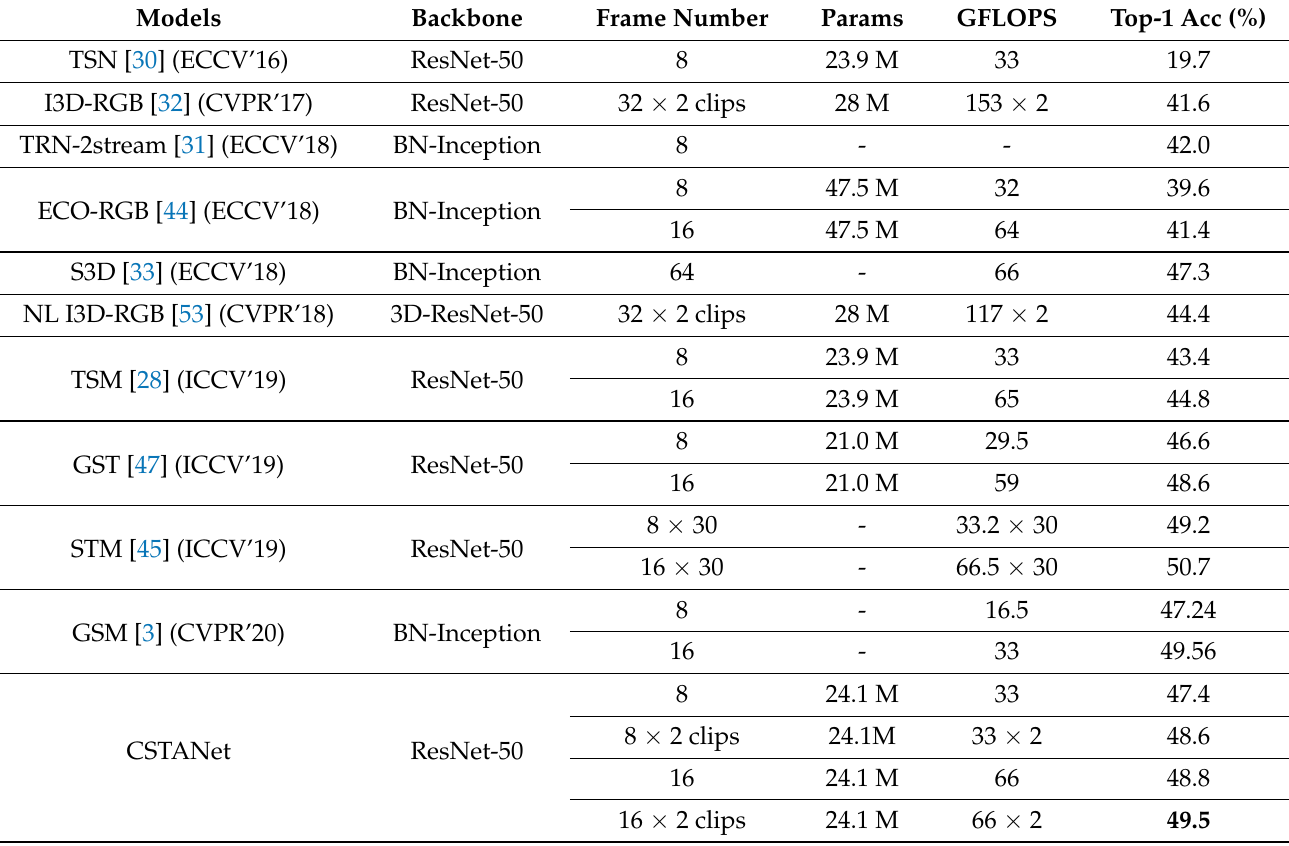
Table 3. The state-of-the-art results on the Something-Something V1 validation set.